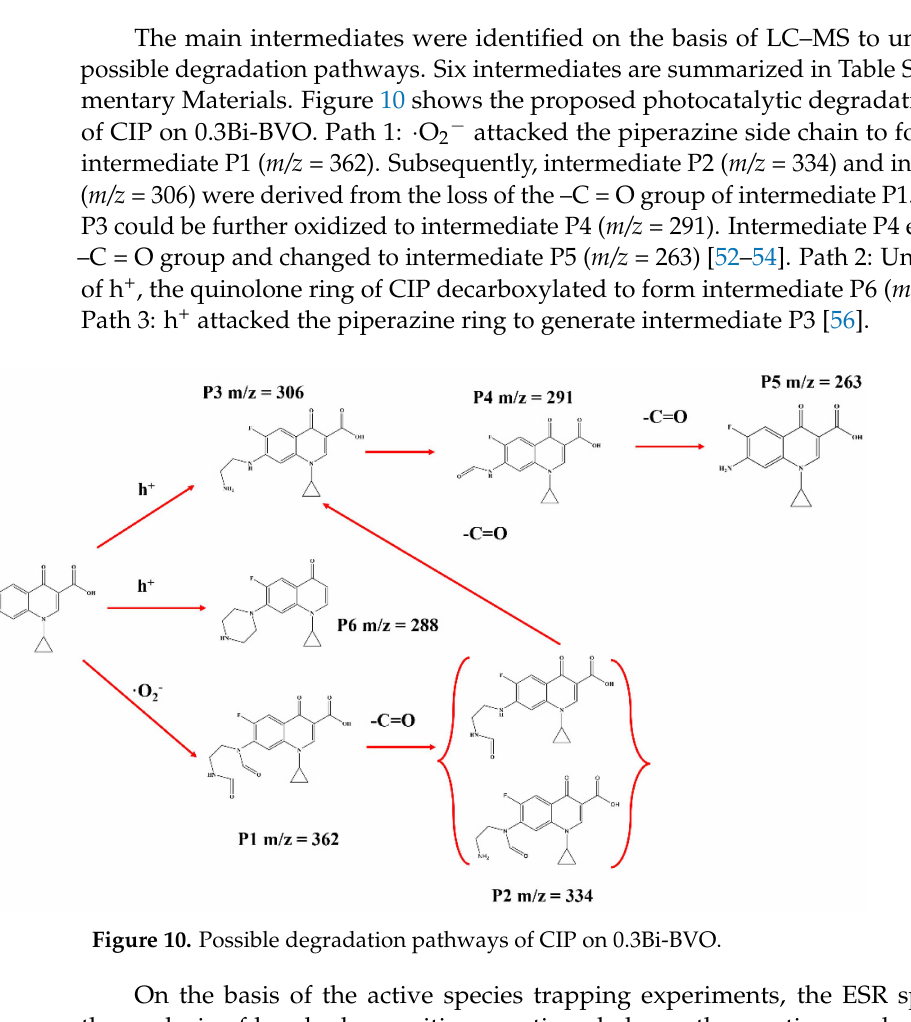
Figure 9. ( a ) PL spectra and ( b ) photocurrent responses of BiVO 4 and Bi/BiVO 4 .